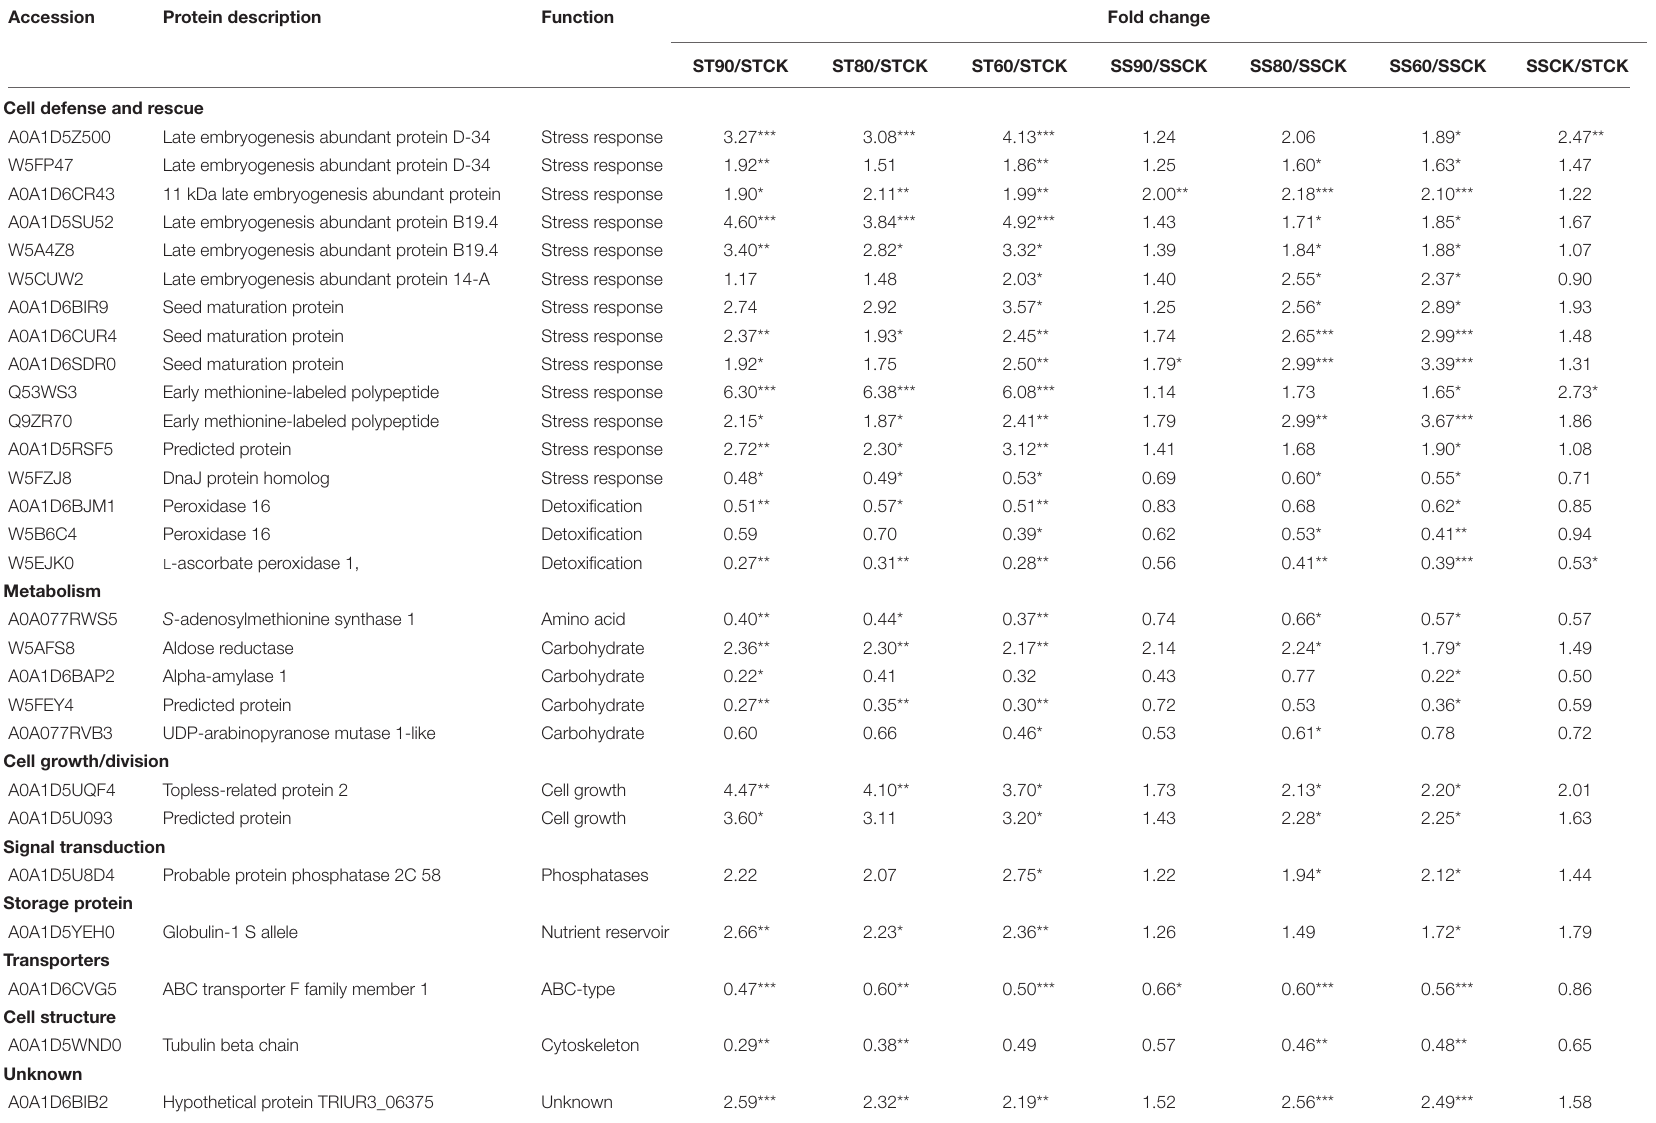
TABLE 3 | List of common differentially abundant proteins with significant trend in both in embryos of ST and SS seeds during artificial aging at 40 ◦ C and 75% relative humidity. Accession Protein description